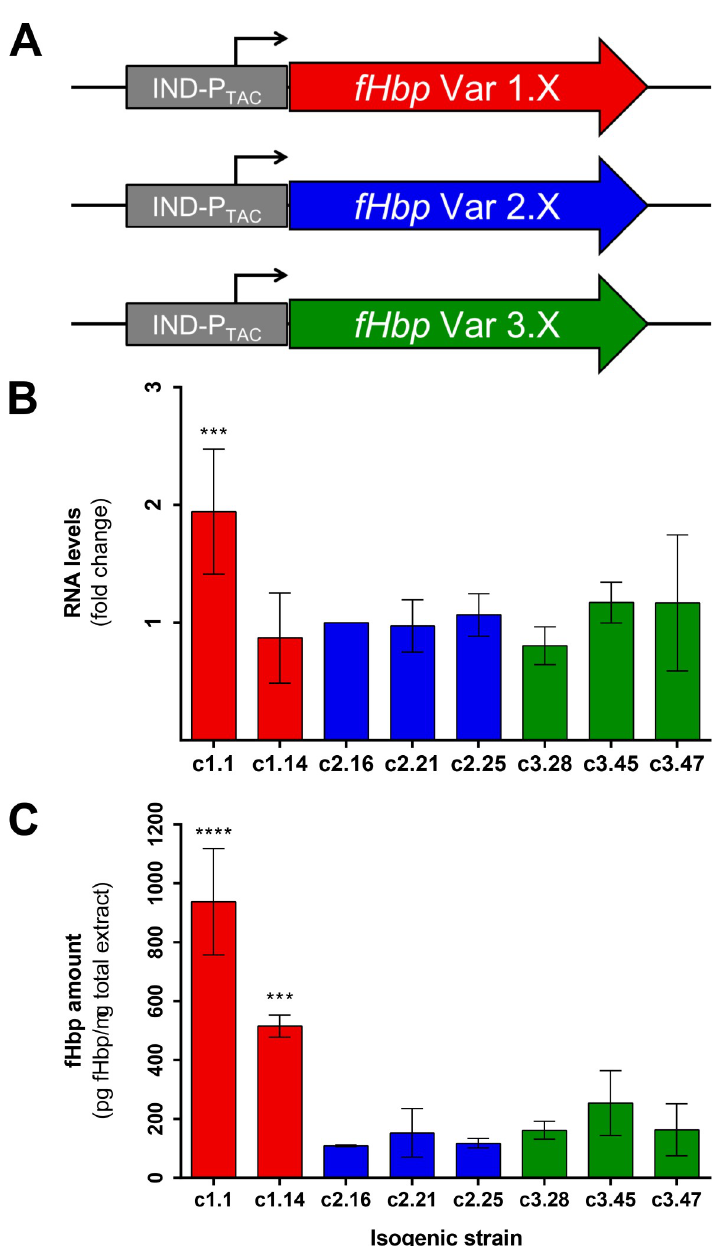
Fig 5. Influence of the variant sequence on the expression levels of fHbp. (A) Schematic representation of the isogenic recombinant mutants generated. The IPTG-inducible promoter is colored in grey. fHbp peptides are colored in red, blue or green according to their variant group 1, 2 or 3, respectively. Results on the expression levels of fHbp in three biological replicates as measured by qRT-PCR (B) and SRM-MS fHbp protein quantification analyses (C) are reported. Values on the RNA levels are normalized to the reference genes 16S RNA and adk and to the c2.16 strain. p - values were obtained through Tukey’s post-test after one-way ANOVA test.